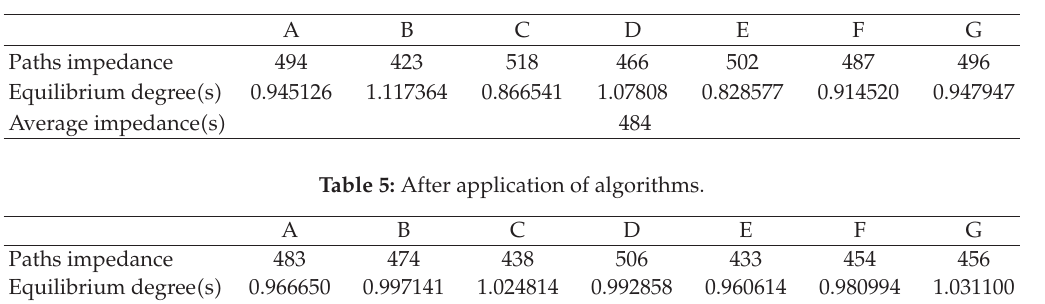
Table 4: Before application of algorithms.